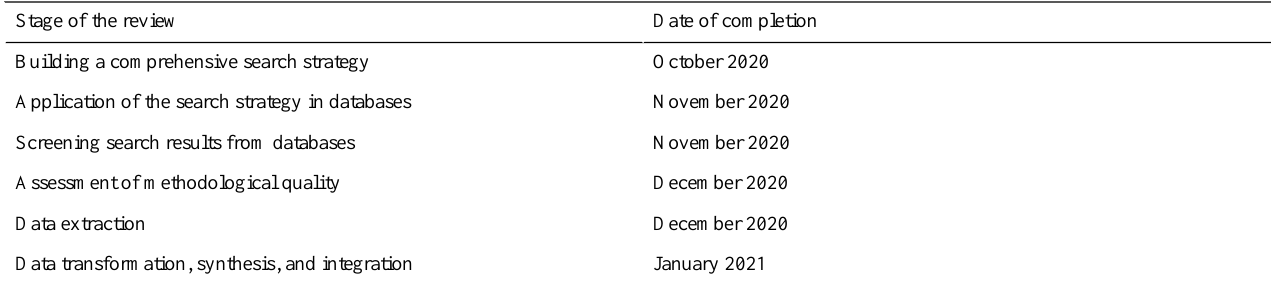
Table 3. Timeline of completion of the stages of mixed methods